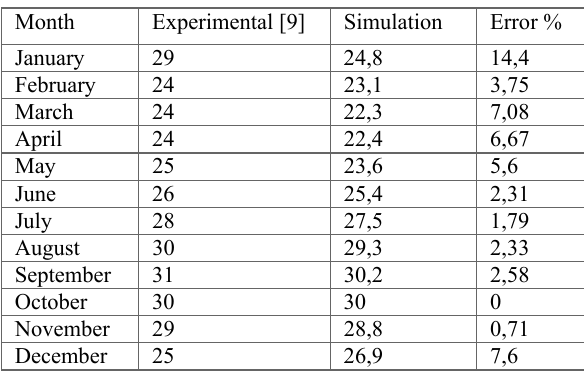
Table 4. Verification of the soil temperature against experimental data of al-Ajmi et al. [15].